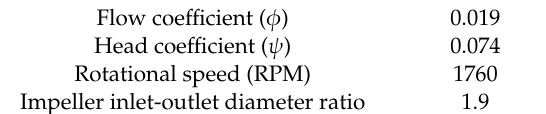
Table 1. Design major specifications of the single-channel pump [23].